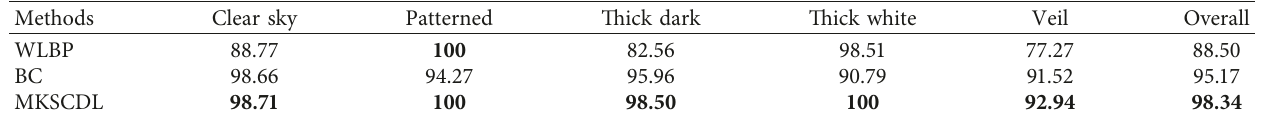
Table 2: Recognition rates of different methods in 10-fold cross validation (%).